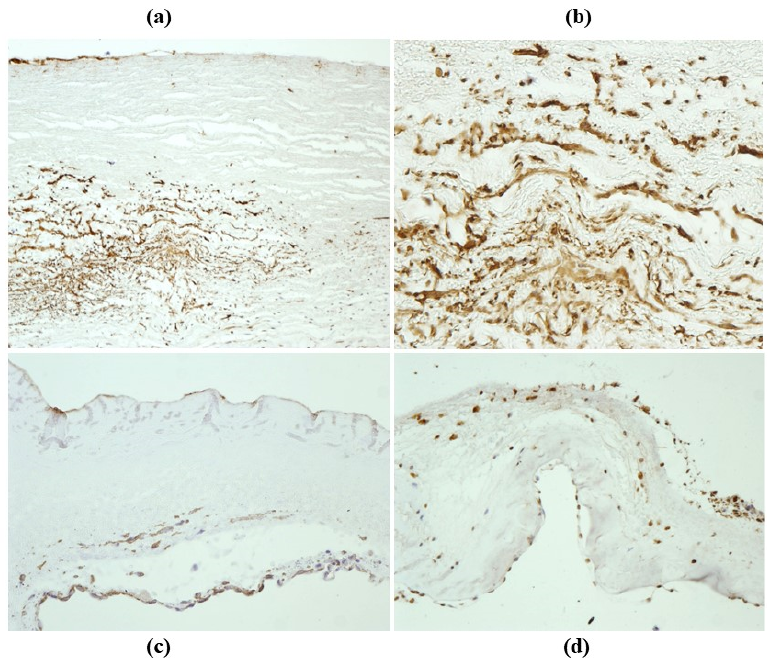
Figure 32. Repopulation by smooth muscle cells of the outer aortic wall ( a , b ) with neo endothelial lining ( a ) of a decellularized homograft, 14 months from implant (anti- α -SMA). ( c , d ) Repopulation after 14 months of implantation of decellularized homograft aortic cusps by smooth muscle cells and endothelial cells (anti- α -SMA and VWF). From [67], with permission.